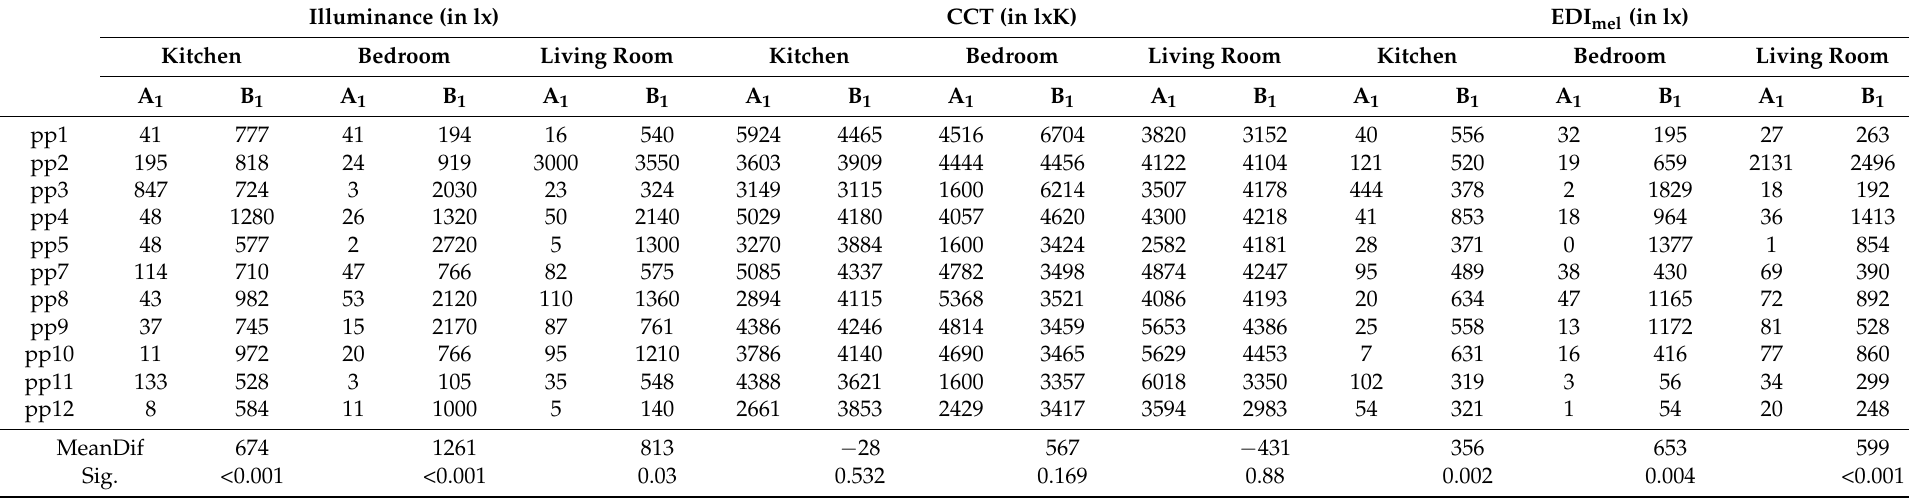
Table 3. Results of the illuminance, CCT, and EDI mel spectrometer values in phases A 1 and B 1 for the kitchen, bedroom, and living room measured vertically at eye level. Illuminance (in lx) CCT (in lxK) EDI mel (in